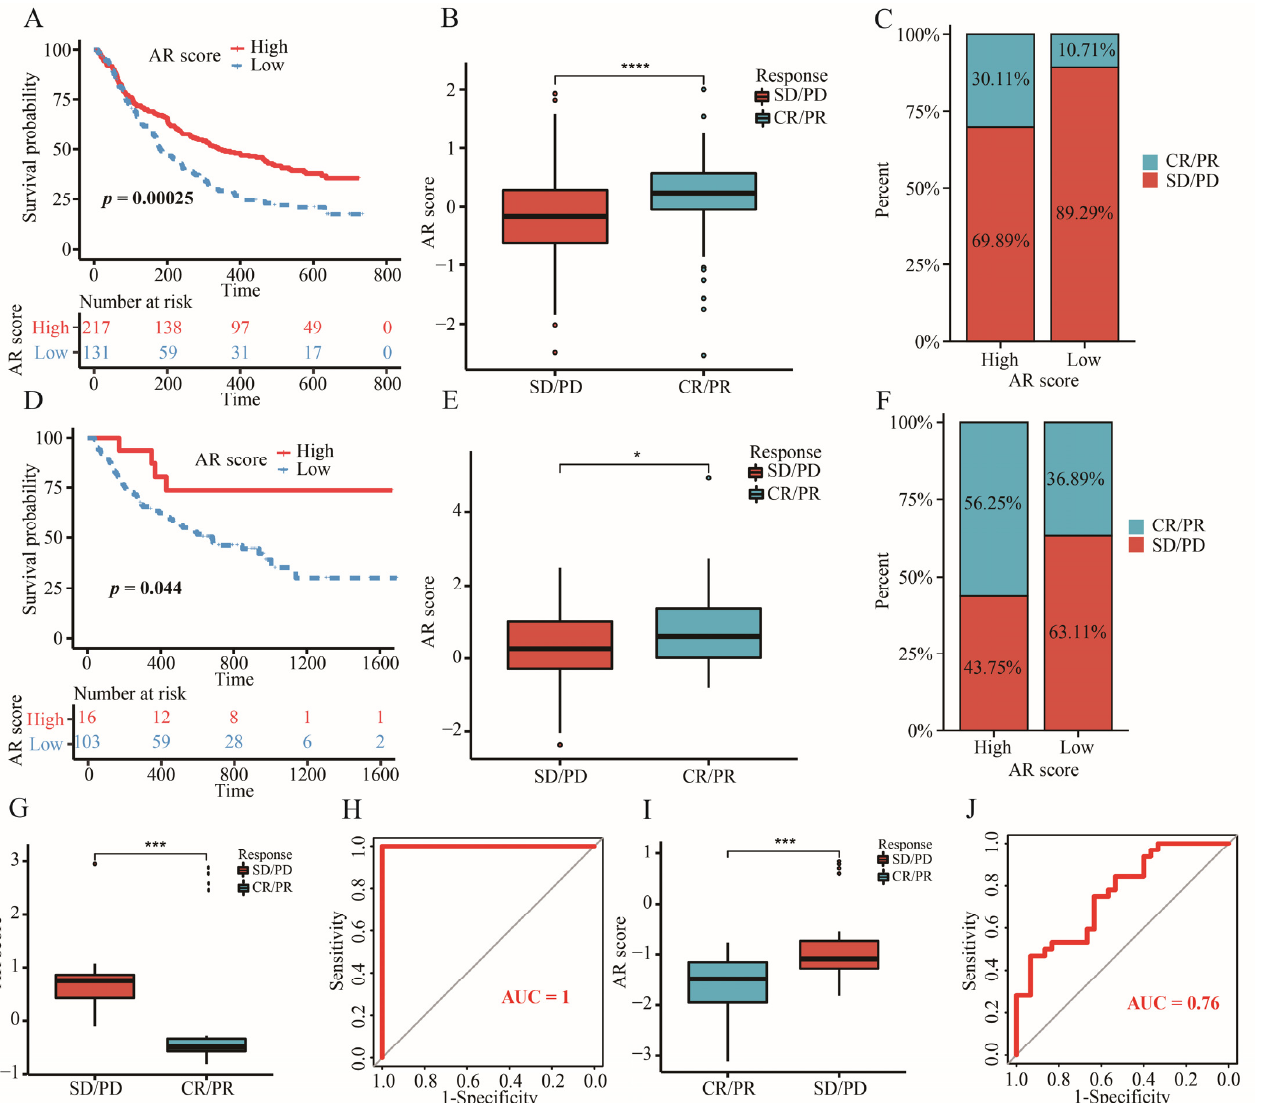
Figure 11. The significance of our signature in various external immunotherapy cohorts. ( A ) Kaplan–Meier survival analysis of OS between high- and low-AR groups in IMvigor210 cohort. ( B ) The comparison of AR scores between CR/PR and SD/PD groups in IMvigor210 cohort. ( C ) The clinical response rate between high- and low-AR groups in IMvigor210 cohort. ( D ) Kaplan–Meier survival analysis of OS between high- and low-AR groups in Liu’s cohort. ( E ) The comparison of AR scores between CR/PR and SD/PD groups in Liu’s cohort. ( F ) The clinical response rate between high- and low-AR groups in Liu’s cohort. ( G ) The comparison of AR scores between CR/PR and SD/PD groups in GSE79671. ( H ) The AUC of predicting patients’ response to bevacizumab treatment in GSE79671. ( I ) The comparison of AR scores between CR/PR and SD/PD groups in GSE148476. ( J ) The AUC of predicting patients’ response to ICIs in GSE148476. Data in ( B , E , G , I ) were analyzed by Wilcoxon test; * p < 0.05, *** p < 0.001 and **** p < 0.0001 .